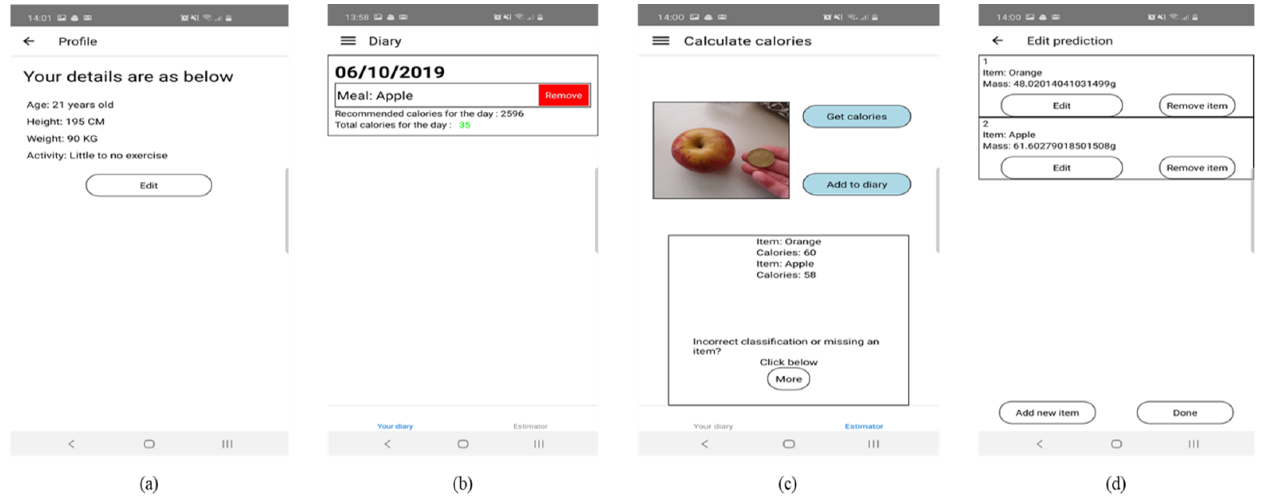
Figure 6. Di ff erent components of front-end: ( a ) user pro fi le, ( b ) diary component and database, Figure 6. Different components of front-end: ( a ) user profile, ( b ) diary component and database, ( c ) food classi fi er component, and ( d ) food correction component. ( c ) food classifier component, and ( d ) food correction